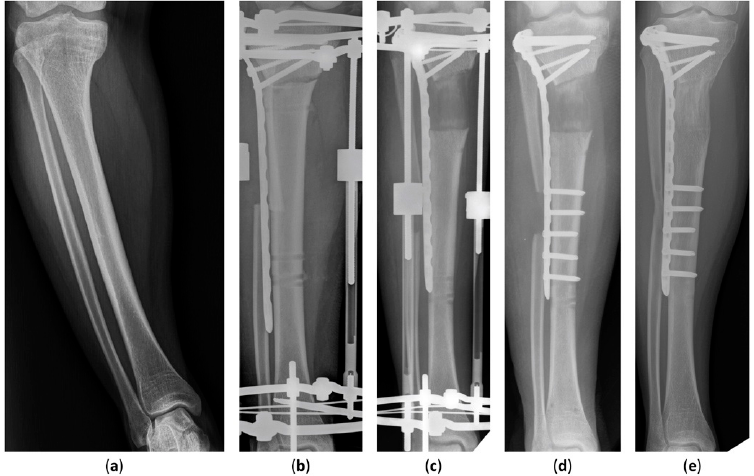
Figure 2. Anteroposterior radiographs of an 18-year-old girl who underwent fixator-assisted plating and acute angular correction for leg-length discrepancy. ( a ) A preoperative anteroposterior view of the tibia. ( b ) The procedure was conducted using an Ilizarov apparatus and a submuscular plate. ( c ) Satisfactory tibial lengthening and alignment were achieved. ( d ) The distal part of the submuscular plate was fixed at removal of the external fixator. ( e ) The distracted callus healing with good consolidation was seen in the latest radiograph 40 months after the operation.